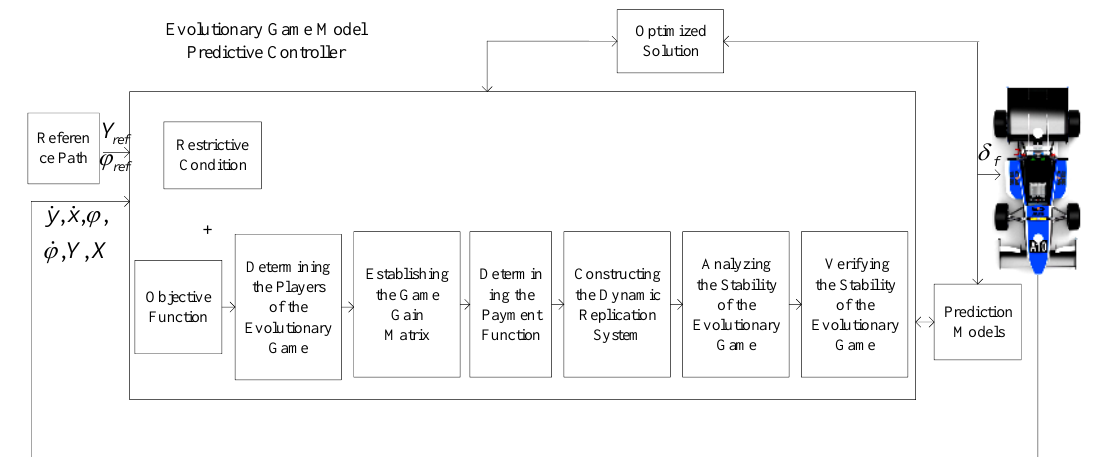
Figure 1. Game theory based on trajectory tracking control strategy.